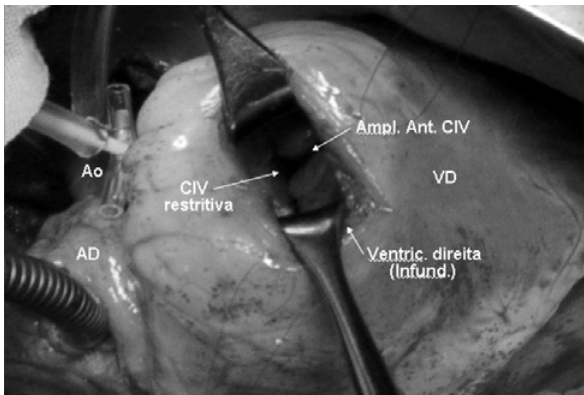
Fig. 2 - Fotografia cirúrgica. Paciente em perfusão, com cânulas em aorta (Ao) e veias cavas, canuladas pelo átrio direito (AD). Abordagem feita pelo ventrículo direito (VD), mediante ventriculotomia direita (Ventriculot. direita) ao nível do infundíbulo (Infund.), observa-se comunicação interventricular (CIV) restritiva. Feita a ampliação anterior da CIV (Ampl. Ant.